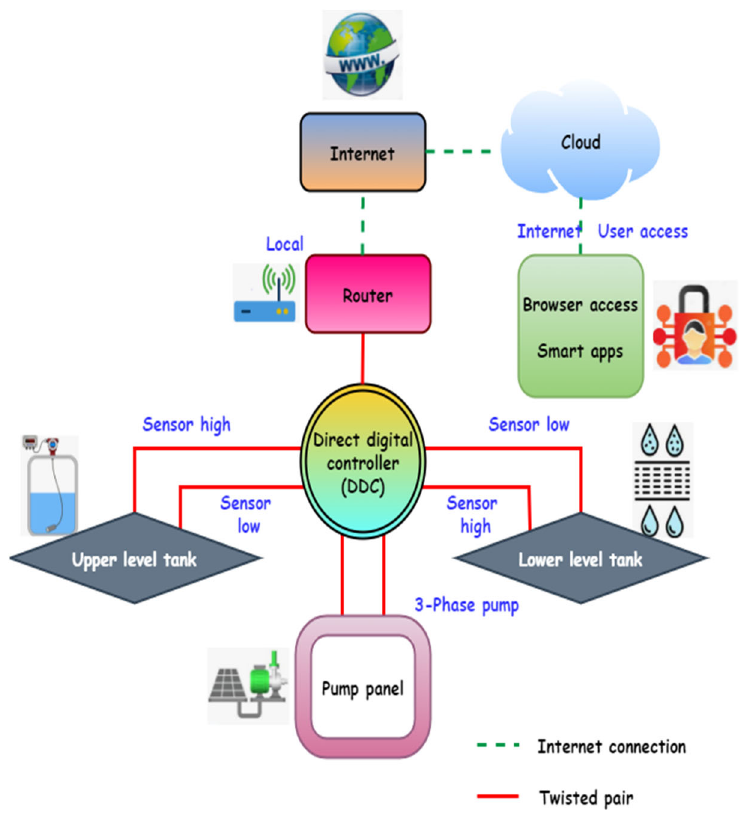
Figure 2. IoT ‐ based smart water management systems. Figure 2. IoT-based smart water management